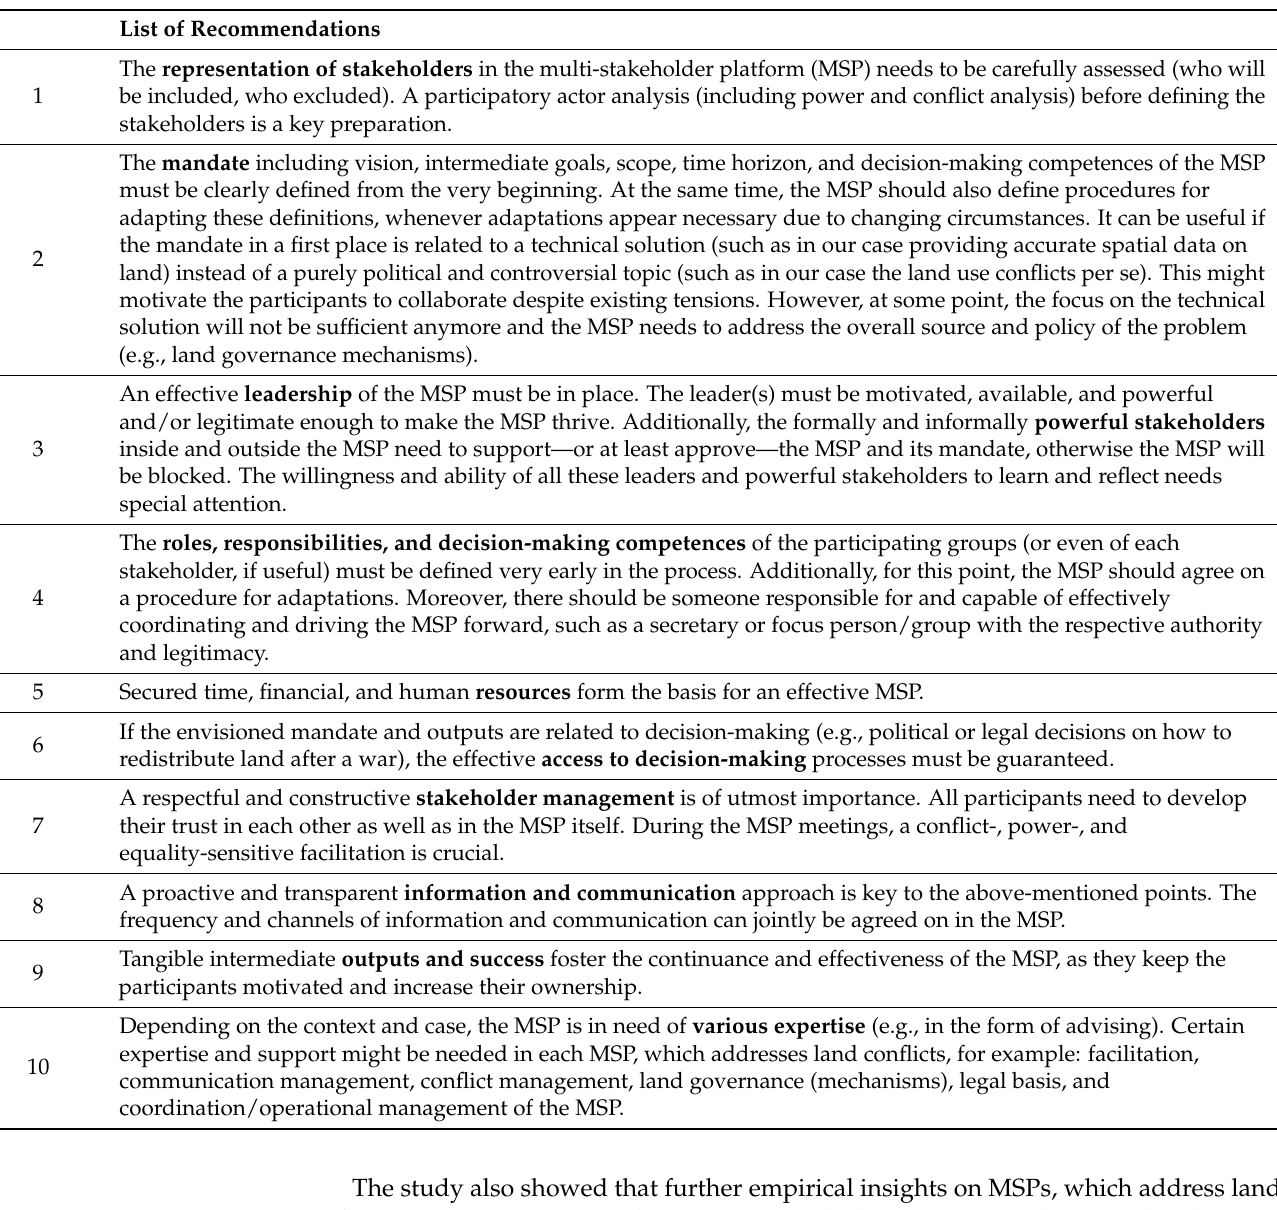
Table 5. Recommendations for designing and governing an effective multi-stakeholder platform (MSP) in a setting of entrenched land conflicts and power